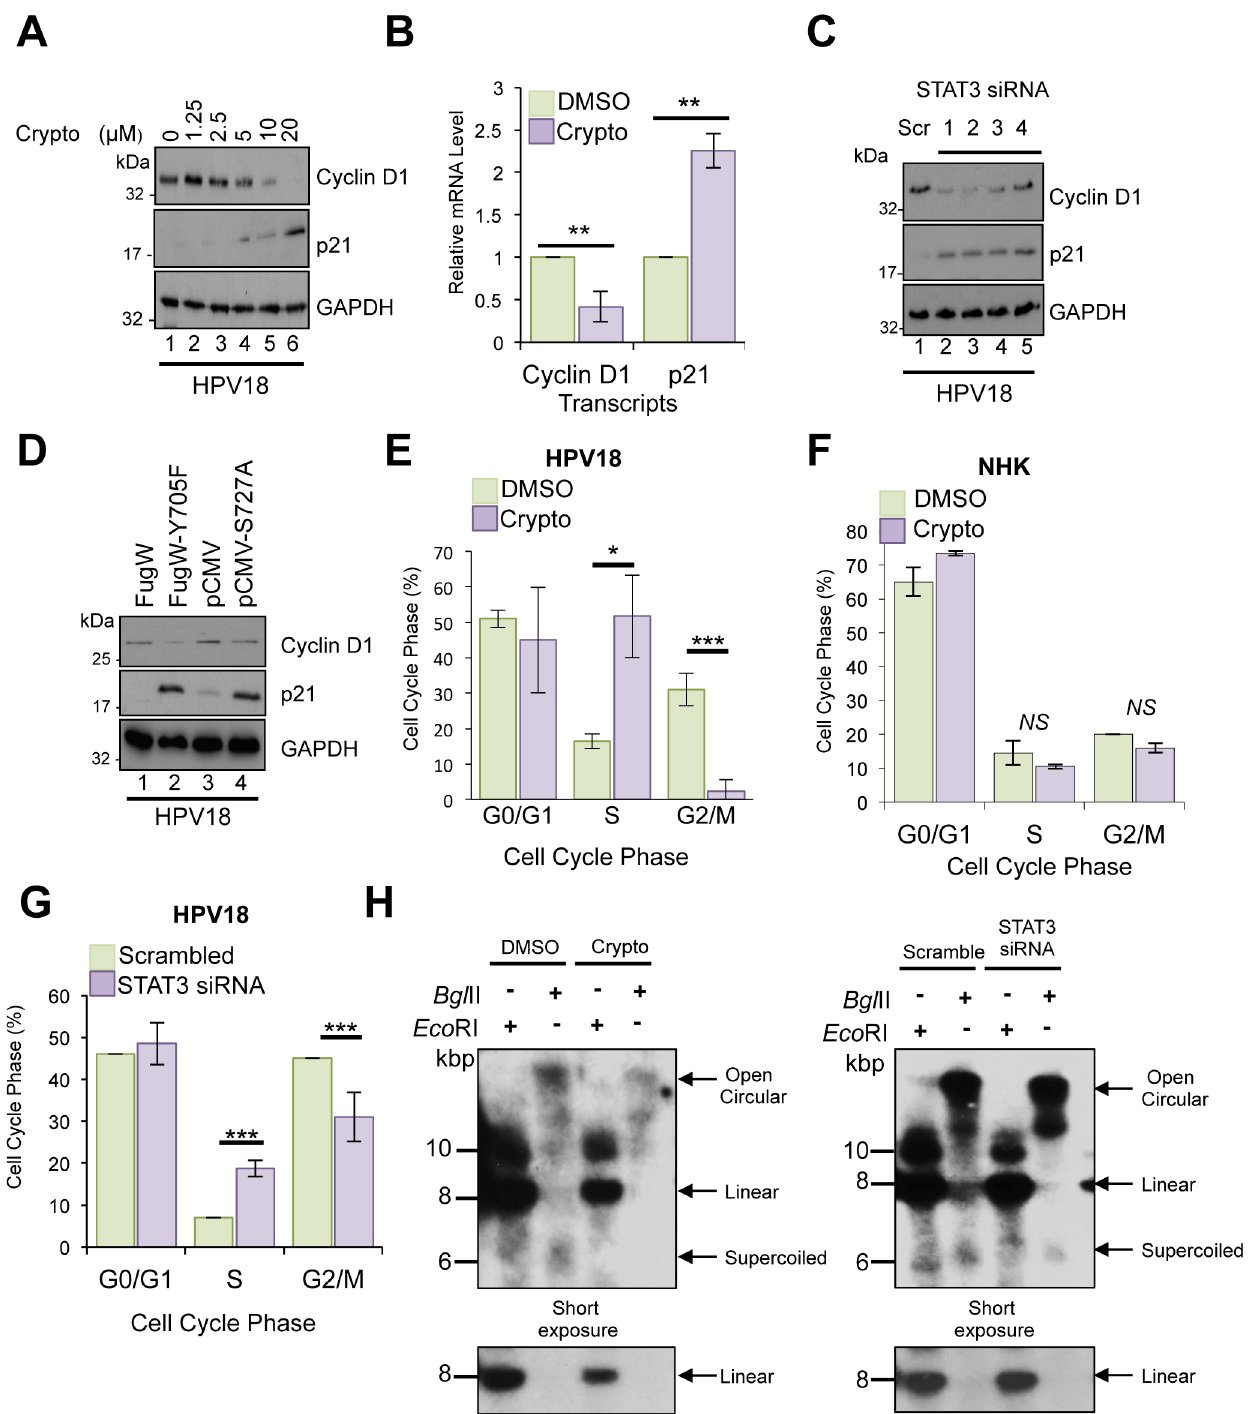
Fig 7. Suppression of STAT3 impairs cell cycle progression and HPV genome maintenance in undifferentiated keratinocytes. A) Representative western blots from HPV18 containing keratinocytes treated with increasing doses of the STAT3 inhibitor cryptotanshinone and analysed with antibodies specific for cyclin D1 and p21. GAPDH served as loading control. Data are representative of at least three biological independent repeats. B) RNA was extracted from HPV18 containing keratinocytes incubated with 10 μM cryptotanshinone and analysed by qRT-PCR for levels of ccnd1 and p21 mRNA. Samples were normalised against U6 mRNA levels and presented relative to the DMSO control. Bars represent means ± standard deviation of at least three biological repeats. (cid:3)(cid:3) P < 0.01 (Student’s t-test). C) Representative western blots of HPV18 containing keratinocytes transfected with a panel of 4 STAT3 specific siRNA and a scrambled control and analysed by western blotting using antibodies specific for cyclin D1 and p21. GAPDH served as loading control. Data are